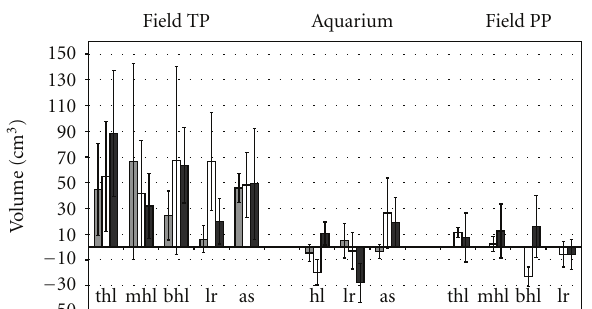
Figure 7: Mean final growth rate (percentage end volume of initial volume) for di ff erent methods. Error bars represent the standard deviation between fragments of specific methods (grey: Neopetrosia sp., white: horizontally cut Stylissa massa , black: vertically cut Stylissa massa , TP: Teluk Pegametan, PP: Pulau Pari, thl: top hor- izontal rope, mhl: middle horizontal rope, bhl: bottom horizontal rope, lr: coral boulders, as: artificial substrate, and hl: horizontal